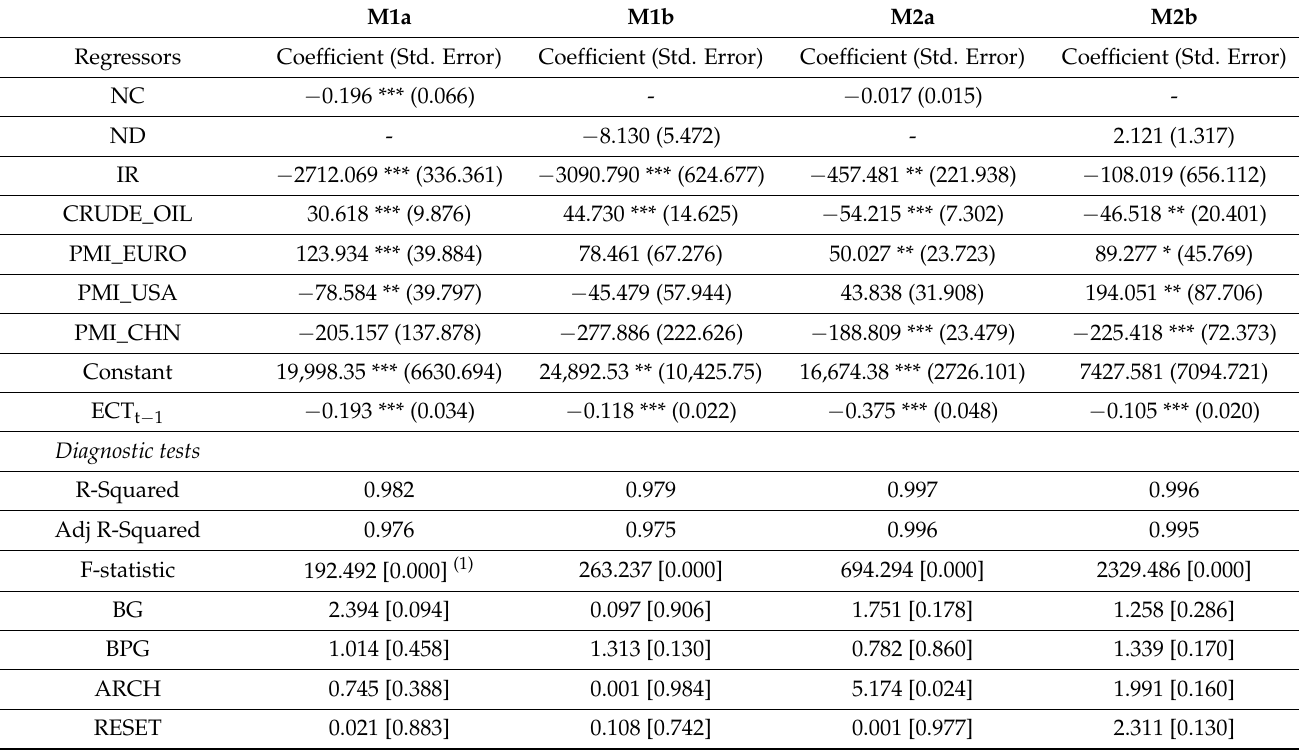
Table 6. Estimated long-run coefficients for the ARDL